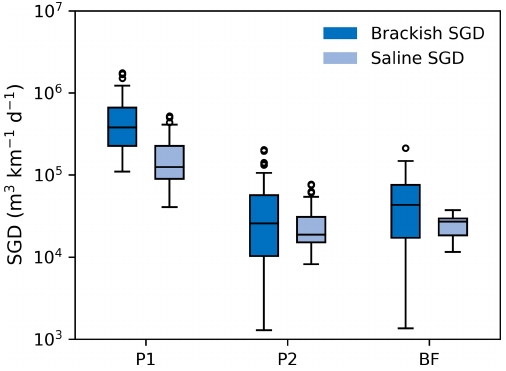
Figure 4. Coastal-normalized flow of brackish and saline submarine groundwater discharge (SGD; dark and light blue, respectively) for the three samplings at Maresme